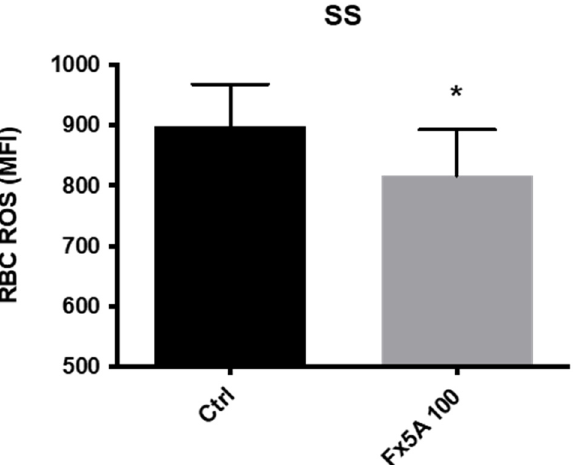
Figure 4. ROS content of RBC from HbSS subjects after incubation with 100 µ g/mL of Fx5A (n = 7). *, p < 0.05. MFI: Median Fluorescence Intensity